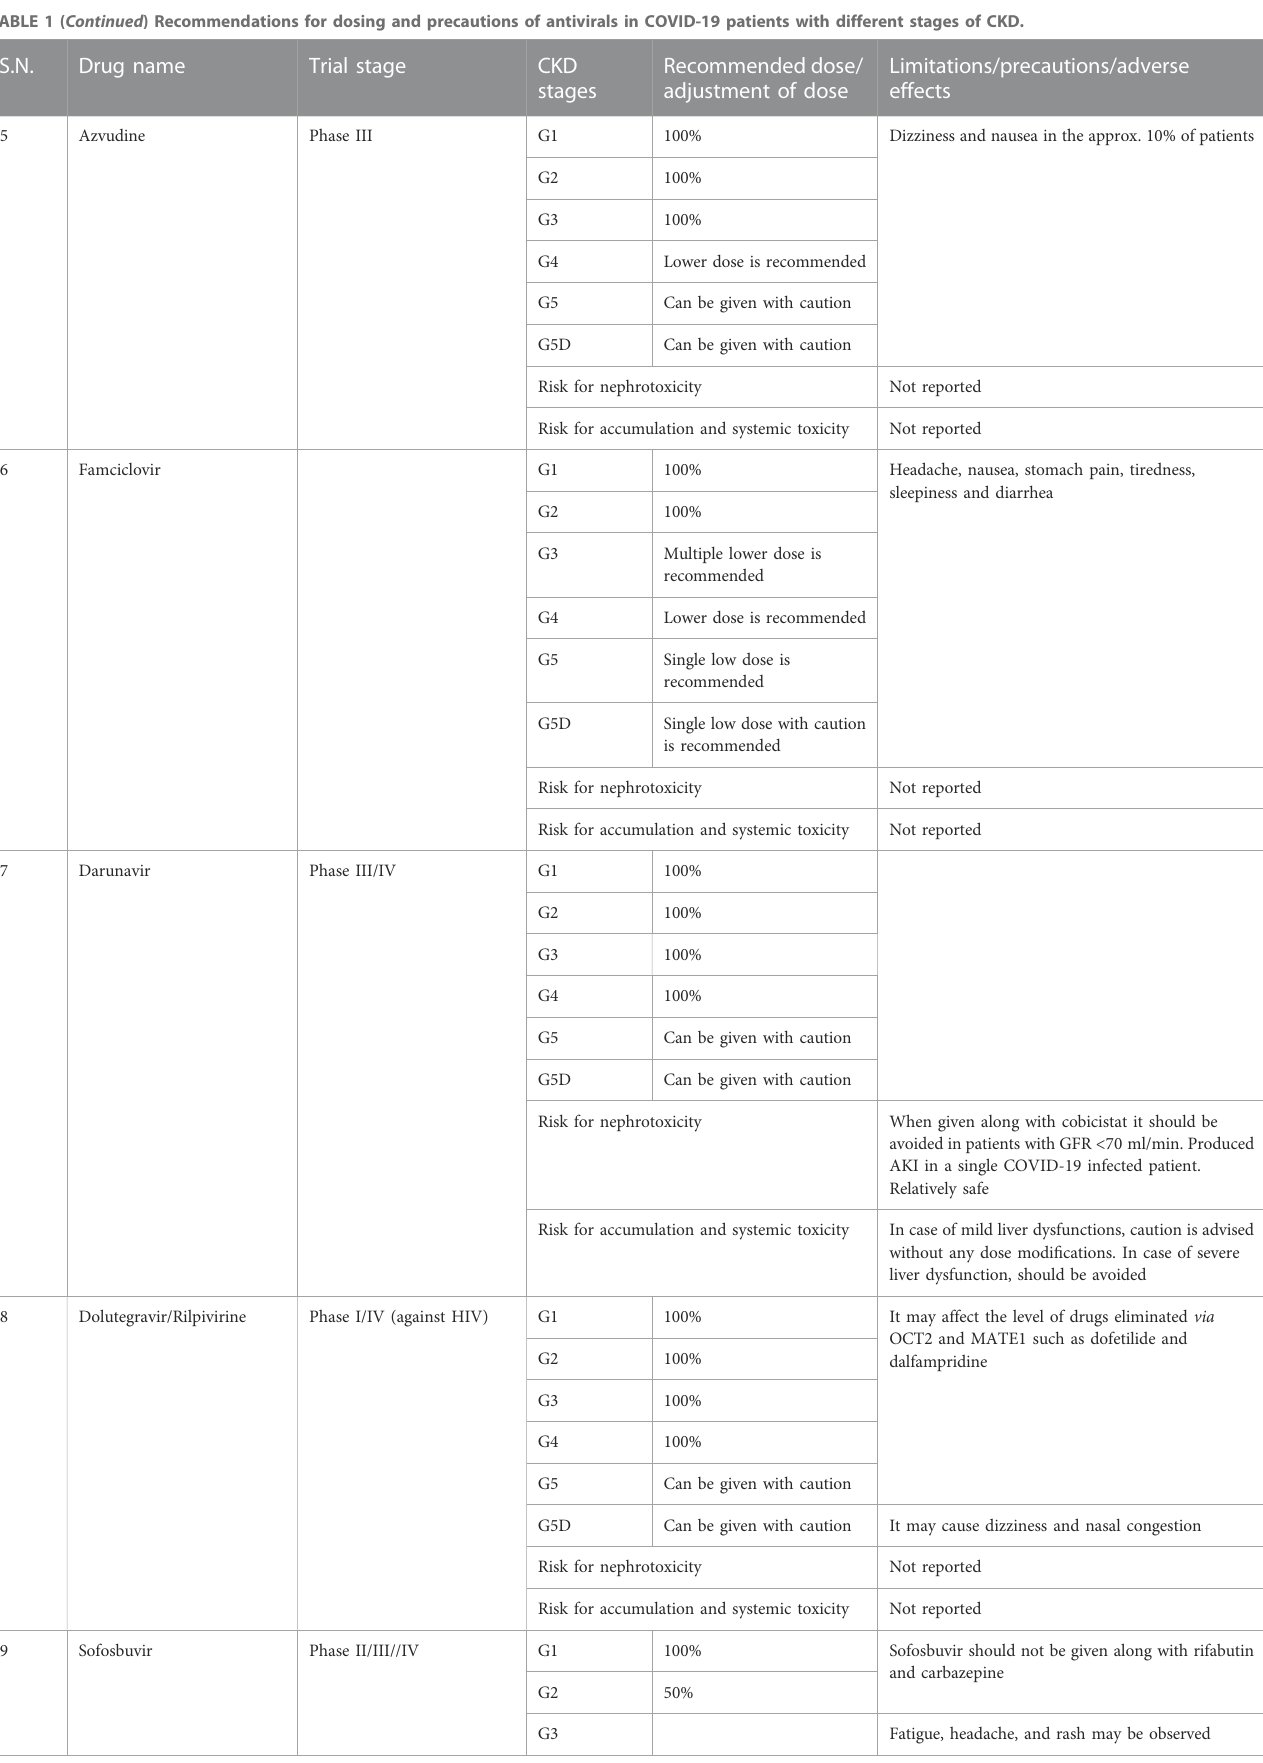
TABLE 1 ( Continued ) Recommendations for dosing and precautions of antivirals in COVID-19 patients with different stages of CKD.